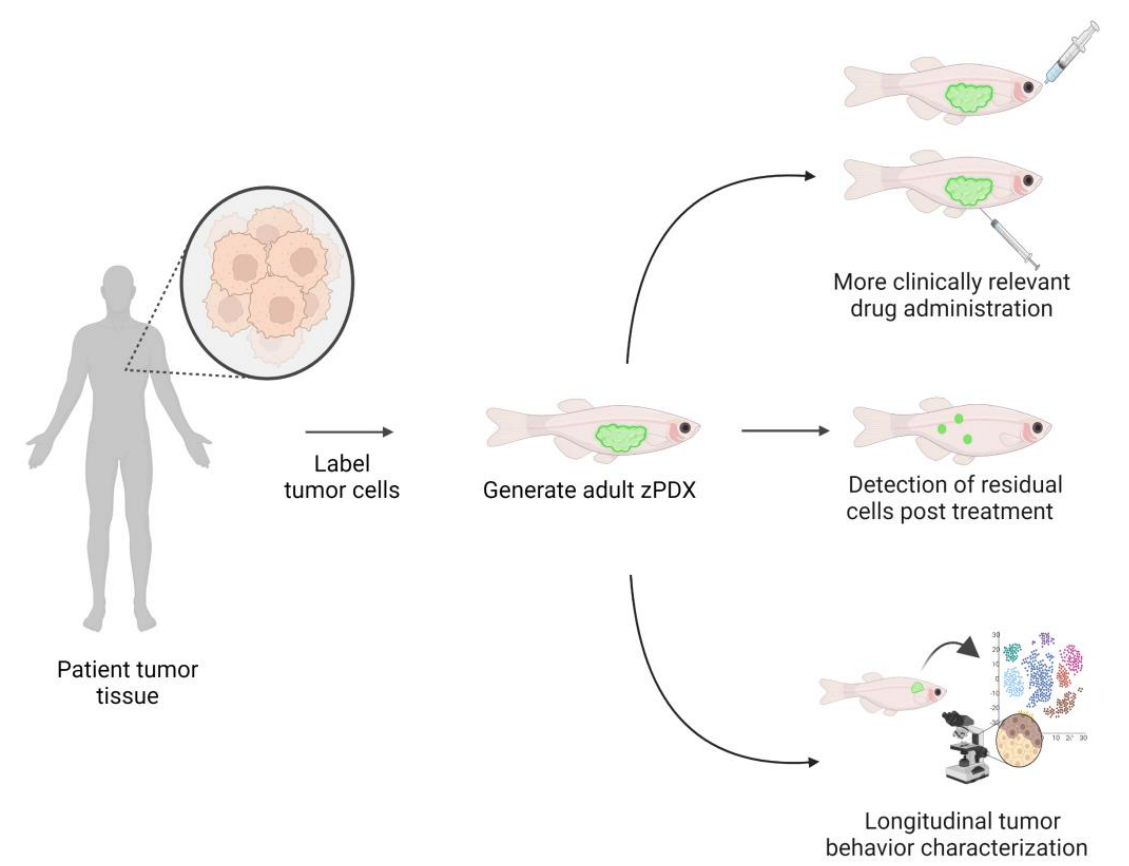
Figure 4. Adult zPDX avatars provide a longitudinal analysis of heterogeneous tumors. Casper - strain prkdc −/− , il2rga −/− immune-deficient zebrafish PDX can be engrafted with up to 10 6 cells, mim- icking the patient’s intra -tumoral heterogeneity in a single animal. Adult zPDX provides a clinically relevant route of drug administration, such as oral gavage and intraperitoneal injection. The optical clarity of the Casper zebrafish enables the detection of residual disease and analysis of relapse phe- notypes. Adult zPDX can maintain engraftment for more than 28 days, which enables extensive evaluation of tumor behavior and therapy response, histological and gene expression analyses re- flect the clonal composition of remining cancer cells (represented in the data plot by different colors).